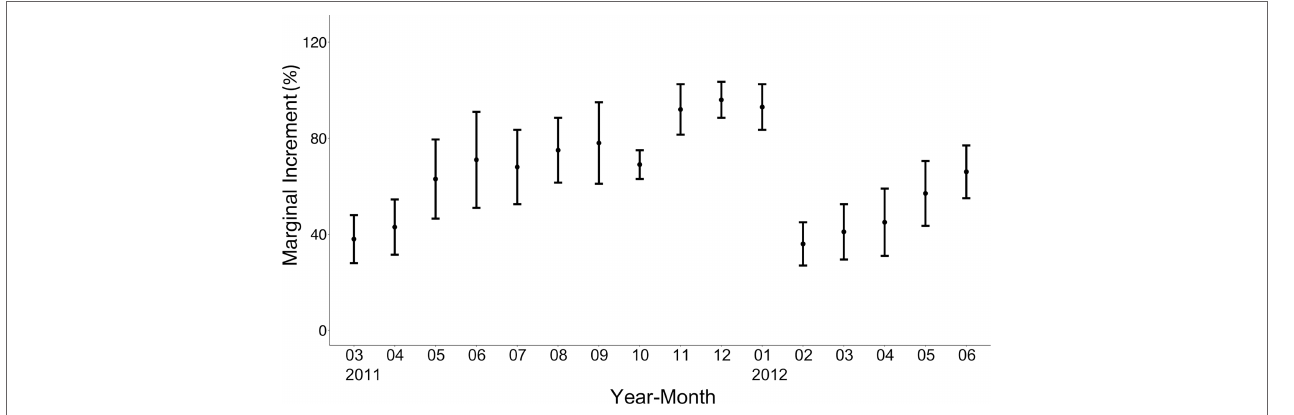
FIGURE 5 | Monthly changes in the marginal increment of the otoliths of brushtooth lizardfish. Vertical bars indicate standard error.